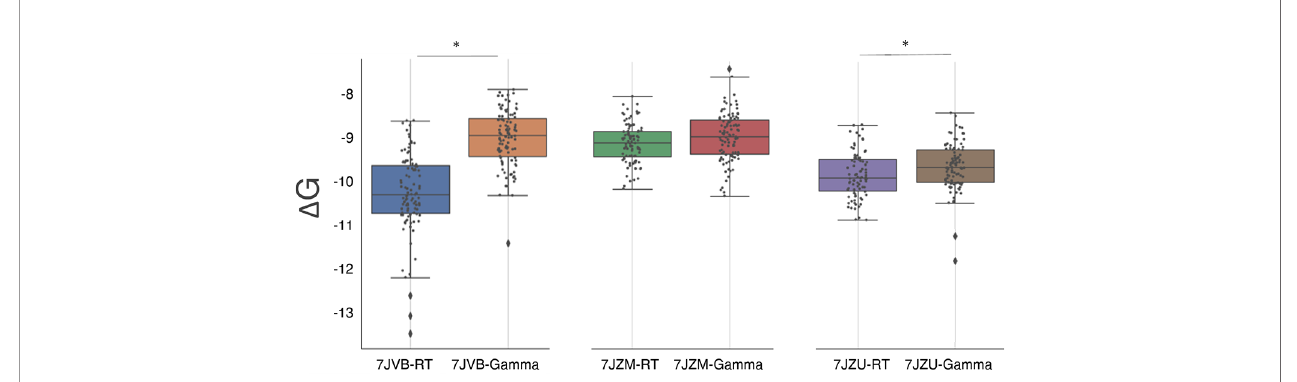
FIGURE 4 | Box plots of the distribution of S-RBD and neutralizing molecules binding free energy (see Figure 3 for the box plot description). The three plots compare the binding free energy of the RT and the gamma variant to three neutralizing molecules (described in the text). Statistically different distributions are indicated with a (*)